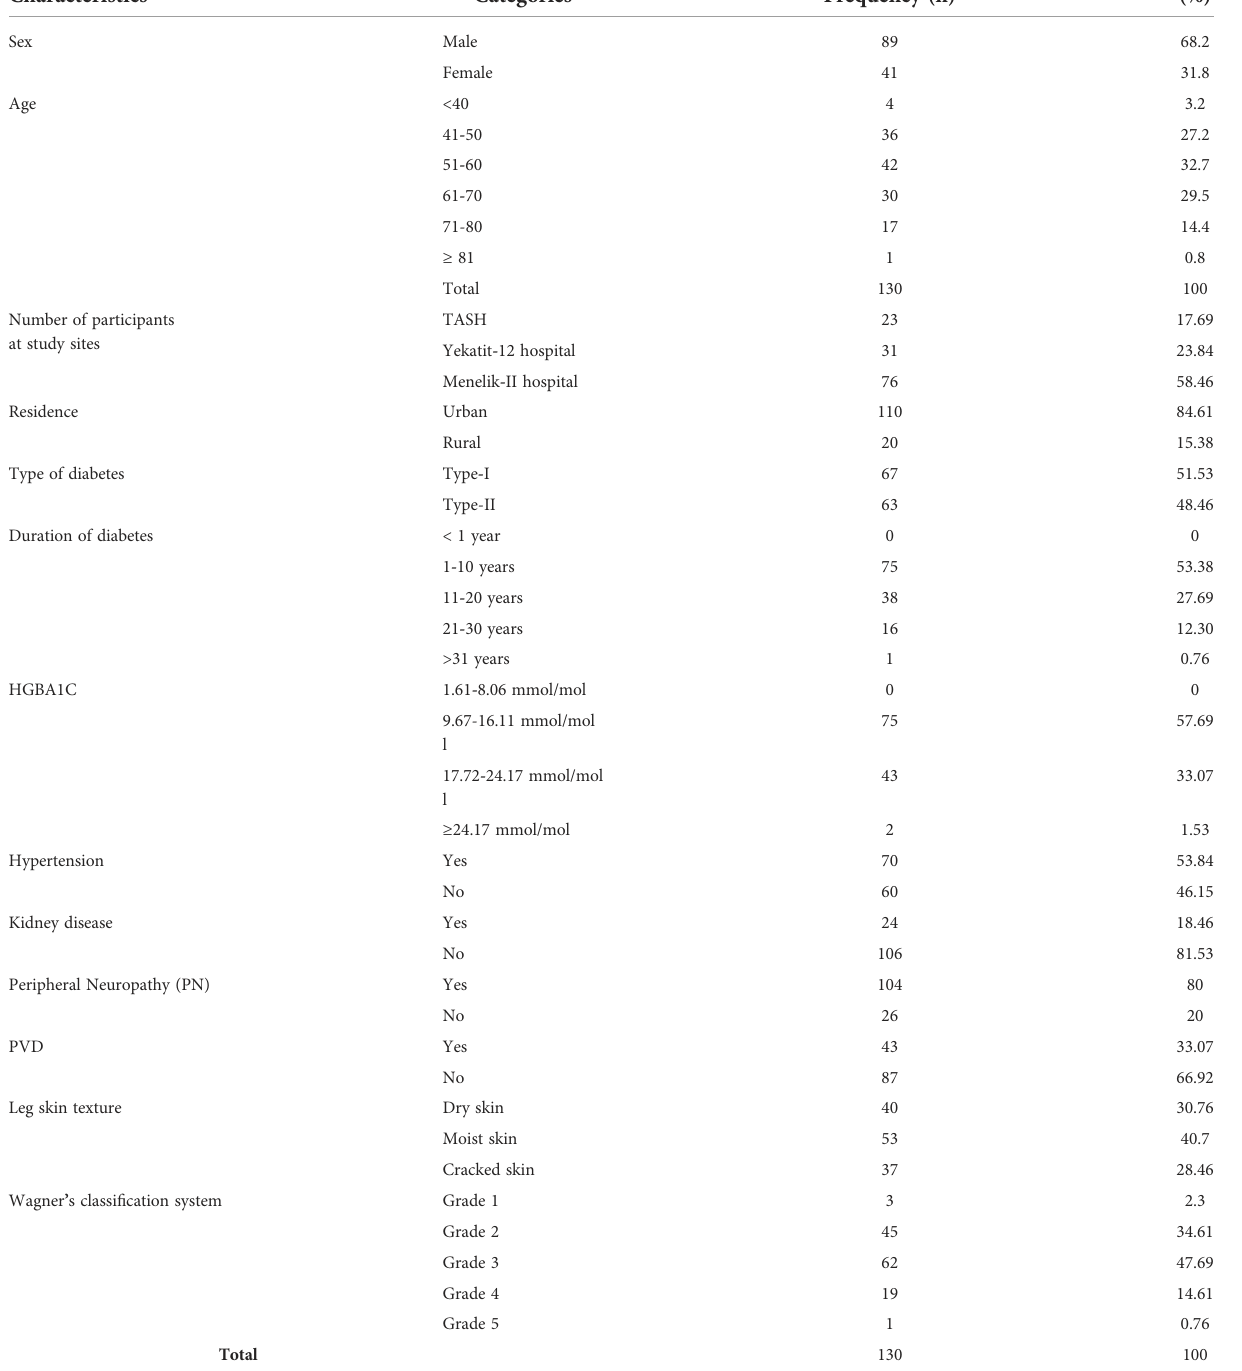
TABLE 1 Sociodemographic and clinical characteristics of the study